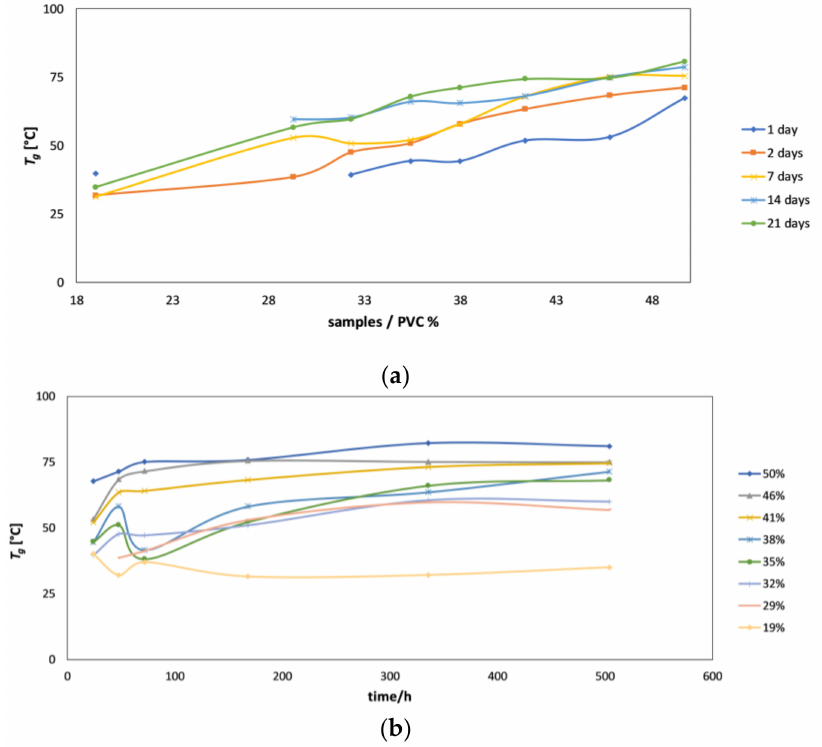
Figure 9. Glass transition temperature ( T g ) measured by dynamic mechanical thermal analysis (DMTA) of the representative samples WB talc coatings series ( a ) and versus time ( b